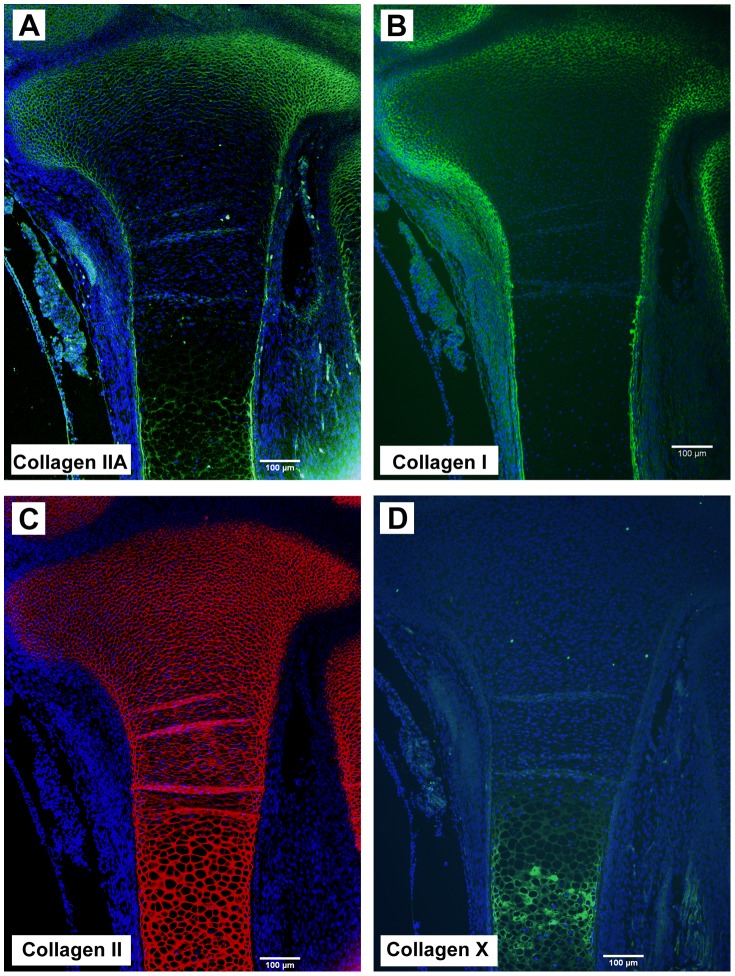
Immunofluorescence staining of different collagen types in a human developing embryonic proximal tibia (gestational day 54).(A) Localization of the embryonic isoform of type II procollagen (type IIA) in the extracellular matrix (ECM). The anti-IIA antibody recognizes the exon 2-encoded cysteine-rich domain present in the amino propeptide of type IIA procollagen [43]. These IIA isoforms are generated predominantly by progenitor chondrocytes seen at the periphery and most proximal area of the developing tibia. Some expression of IIA procollagen has been reported in the pre-hypertrophic and hypertrophic region of developing cartilage [58] and is also shown here. (B) Type I collagen staining is restricted to the areas of precursor chondrocytes and cells of the perichondrium/periosteum. (C) Type II collagen staining patterns (i.e. the processed triple helical domain of type II collagen) is present throughout the entire developing limb. (D) Collagen X staining is restricted to the ECM containing hypertrophic chondrocytes. Cell nuclei are visualized in blue by DAPI staining. Scale bars = 100 µm. Immunofluorescent images are representative of three independent experiments using gestational day 54 tissue sections from different embryos.